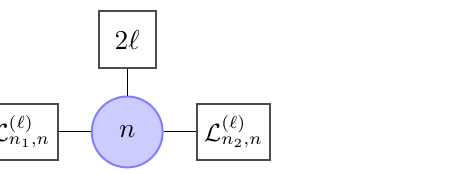
Figure 5 . The left quiver is a weak coupling description of the Lagrangian theory L ( ‘ ) n gauge group is the same as that in (cid:12)gure 3, but the matter sector is composed purely of fundamental and bifundamental hypermultiplets. The rank of the (cid:13)avor symmetry group of L ( ‘ ) n that of T ( ‘ ) n by ‘ . The L ( ‘ ) n theory is obtained by compactifying the 6D (2 ; 0) A n (cid:0) 1 theory 1 ;n;n 2 1 ;n;n 2 on the punctured sphere shown in the right picture. The sphere has 2 n (cid:0) n 1 (cid:0) n 2 (represented by black points) and two additional regular punctures associated with Y ( ‘ ) n The complex structure moduli space of this punctured sphere is identi(cid:12)ed as the conformal manifold of L ( ‘ ) n 1 ;n;n 2